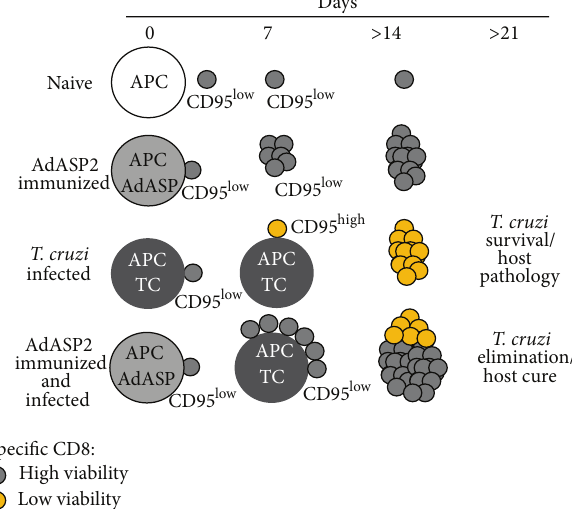
Figure 3: Proposed model for activation of specific CD8 + lympho- cytes during infection of T. cruzi in naive or AdASP-2 immunized mice. Specific CD8 + T cells activated with APC containing T. cruzi antigen induce higher levels of expression of CD95 and low viability of T cells. This poor viability leads to a suboptimal response and host pathology (death or chronic infection). In contrast, the contact of APC pulsed with recombinant ADASP-2 activates specific CD8 + T cells with low expression of CD95. In the second contact with APC pulsed with T. cruzi antigen, specific CD8 + T cells with CD 95 low phenotype develop a strong immune response driving parasite elimination and promoting cure of the